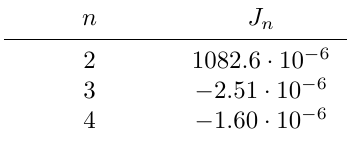
Table 1: Zonal harmonic coefficients (Roy,